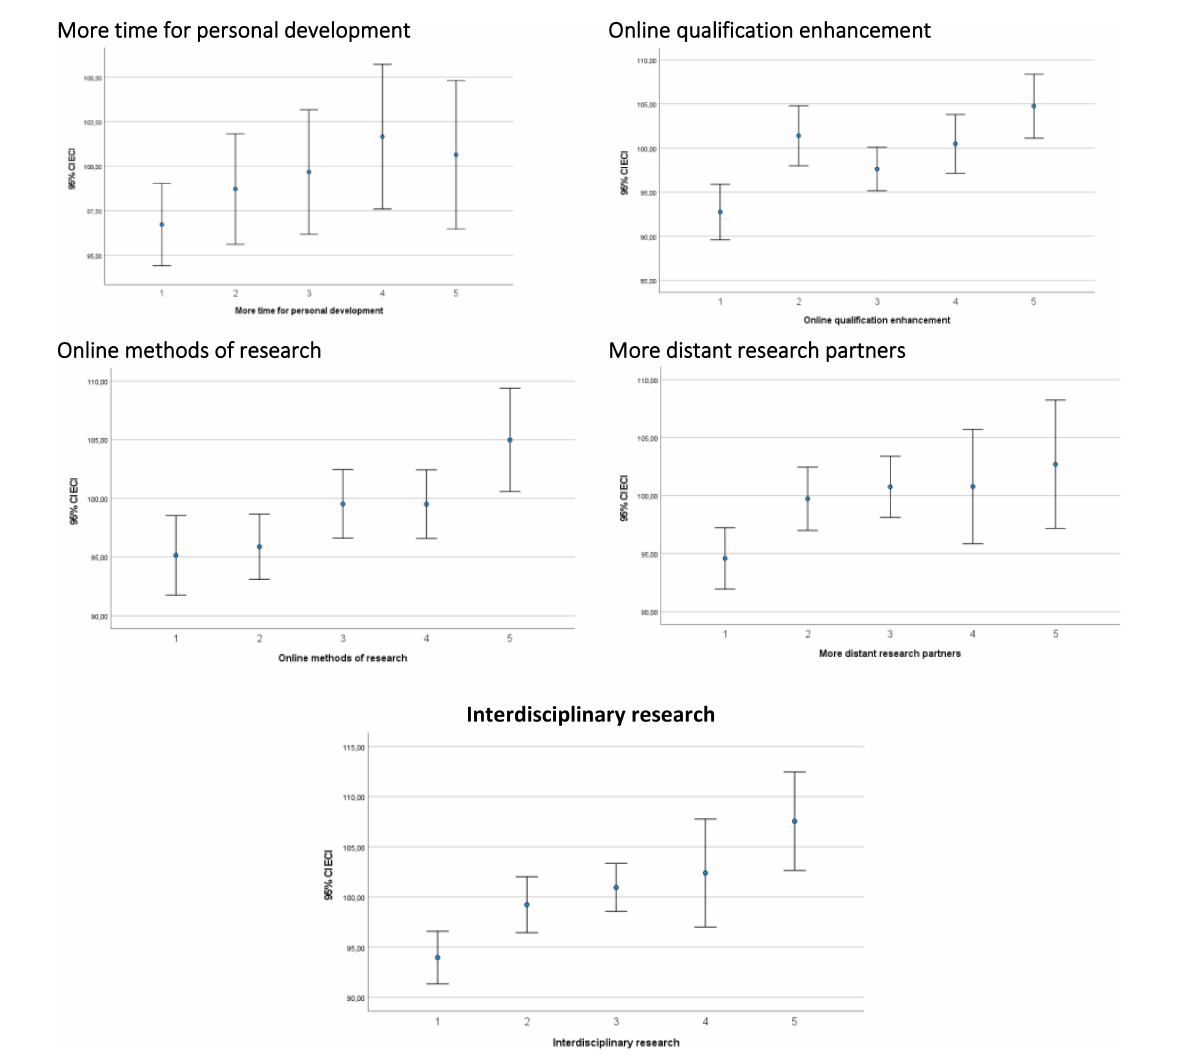
FIGURE1 Emotional creativity inventory (ECI) as related to motivations for innovative behavior. Means and 95% confidence intervals. The scale of indicators of motivation for innovation ranges from 1—strongly disagree to 5—strongly